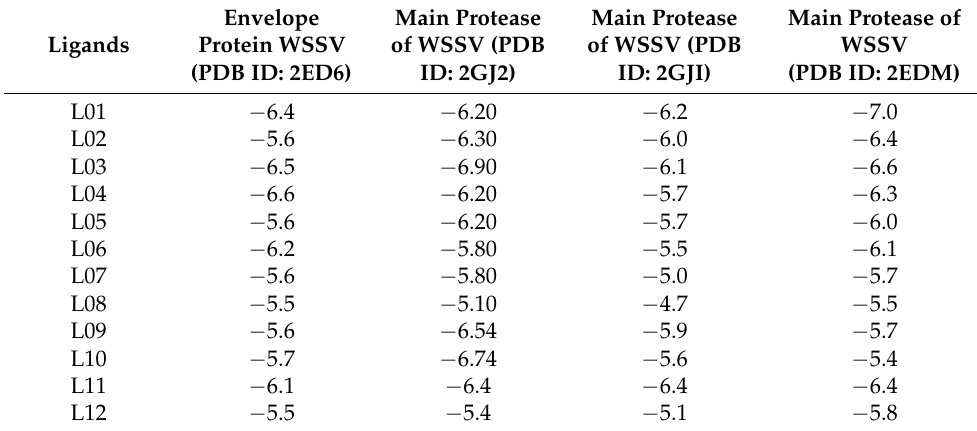
Data of binding energy and name of interacted ligand against WSSV in binding